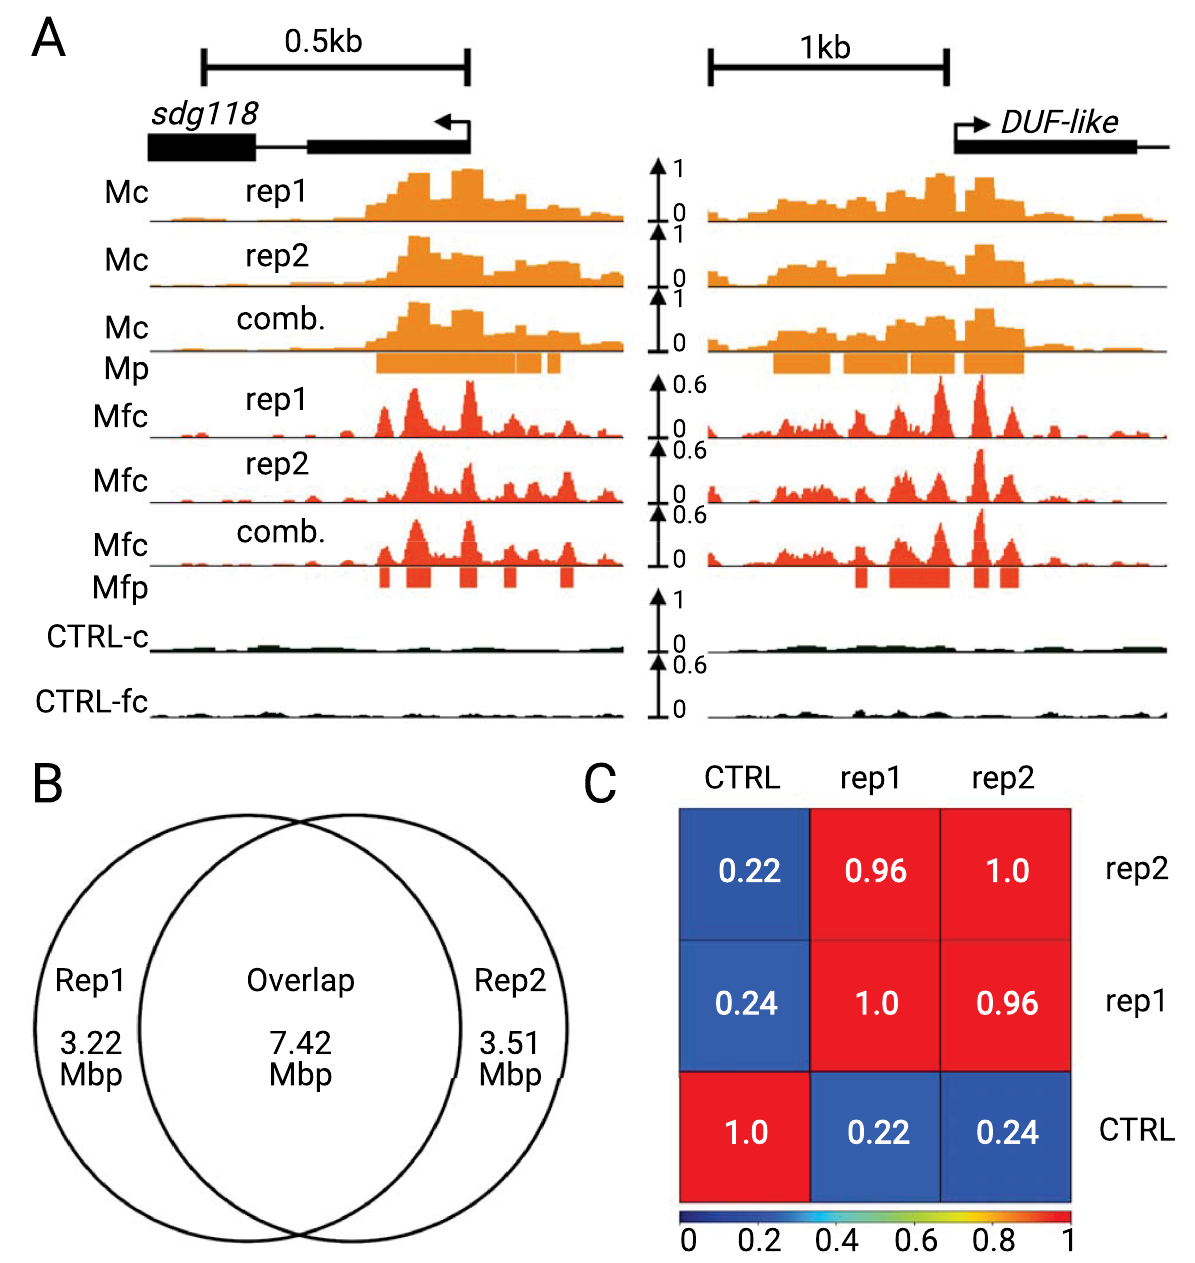
Fig 2. Reproducibility of MOA-seq coverage and footprints from bio-replicate analysis. Comparison of the two bio-replicates, rep1 and rep2, each from ABCD combined (Methods). (A) MOA-seq read coverage (Mc, light orange), MOA footprint coverage (Mfc, dark orange), MNase control coverage (CTRL-c), and MNAse control footprint coverage (CTRL-fc) are shown for two representative areas around the sdg118 gene (left, Zm00001eb363830) and a DUF-like gene (right, Zm00001eb364010). For each example, the peaks for the combined datasets (Mp and Mfp) are shown. (B) Venn diagram of rep1 and rep2 shows the 1-to-1 quantification of overlapping bases within overlapping peaks. The total shared base pairs (7.42 Mbp) represent 69.7% of Rep1 and 67.8% of Rep2 bases in their respective peaks. (C) Biological replicate correlation analysis for replicate 1 (rep1), replicate 2 (rep2) and the MNase control